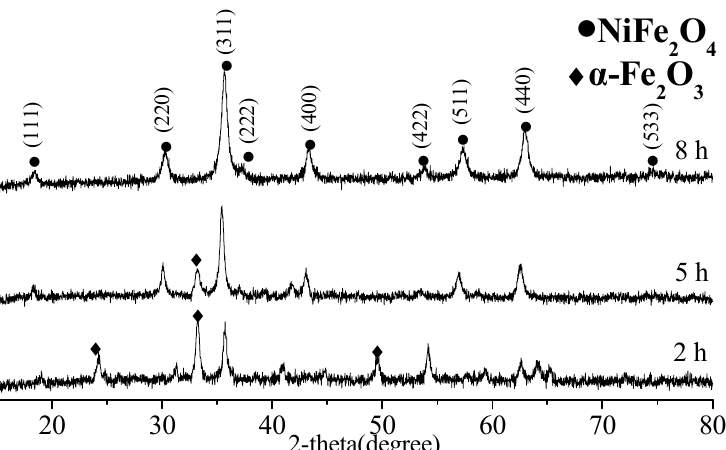
Figure 2. XRD patterns of samples synthesized at 200 °C with different reaction time. Characteristic peaks for α -Fe 2 O 3 and NiFe 2 O 4 are labeled by filled diamond and filled circle, respectively.